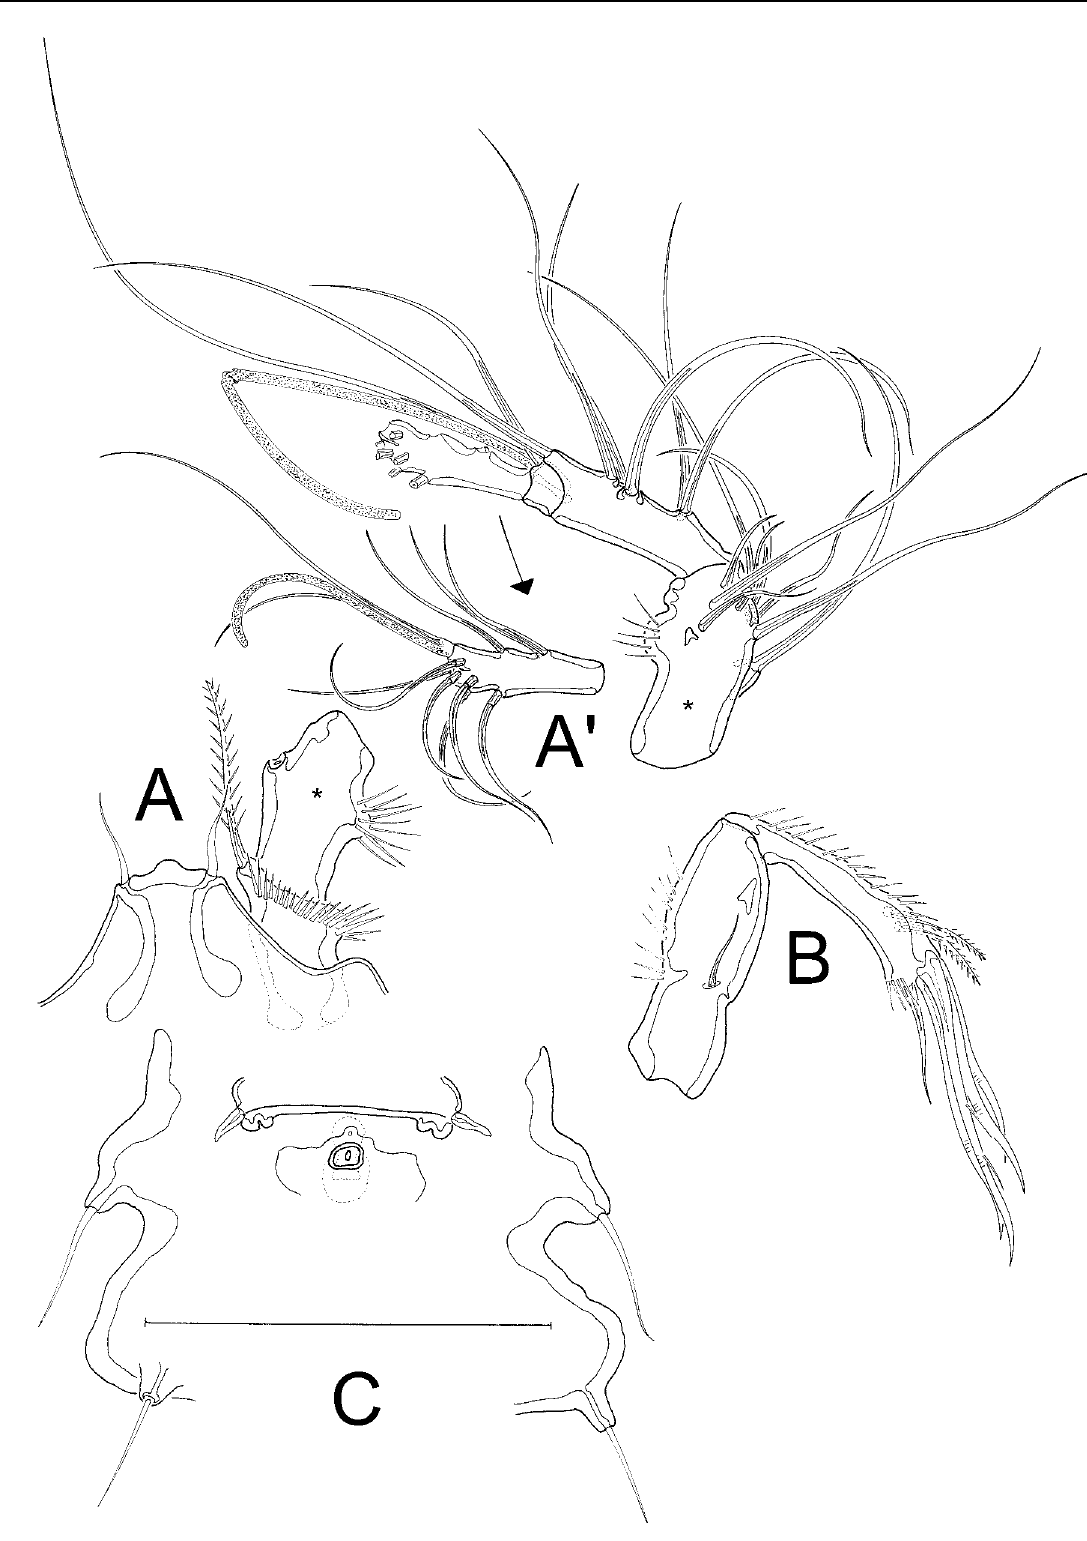
Fig. 3. Laophontodes typicus T. Scott, 1894, ♀ (A–B: BMNH 2015.1144–1153-1; A', C: BMNH 2015.1144–1153-3). A . Rostrum, first and second segment of A1. A’ . Second to fifth segments of A1. Asterisk (*) showing second segment. B . A2. C . Genital double somite with genital field and P6. Scale bar = 50